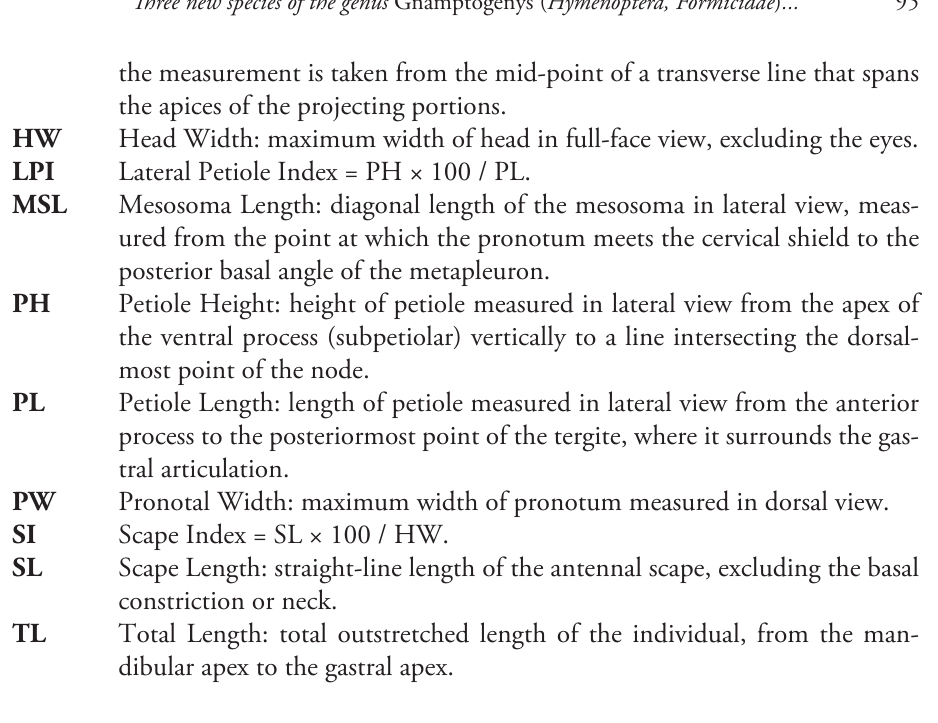
Type material. Holotype. Worker. CHINA: Guangxi, Huanjiang County, Jiuwan Mountain, 25°11'00"N, 108°36'57"E, 925m, 8.VIII.2015, leg. Zhilin Chen, No. G150067. Paratypes. 12 workers and 1 queen, data the same as holotype. [1 worker holotype, 8 workers pratypes and 1 queen paratype specimens are deposited in the Insect Collection, Guangxi Normal University, Guilin, China (GXNU); 2 workers paratypes will be deposited in the Insect Collection, Southwest Forestry University, Kunming, Yunnan Province, China (SWFU); 2 workers paratypes will be deposited in the Institute of Zoology, Chinese Academy of Sciences, Beijing, China (IZCAS)]. Holotype worker (Figs 1–4). TL 4.61, HL 1.45, HW 1.22, CI 84, SL 1.05, SI 86, ED 0.14, PW 0.96, MSL 1.71, PL 0.41, PH 0.95, DPW 0.58, LPI 231, DPI 141. In full-face view head rectangular, longer than broad; posterior margin almost straight,